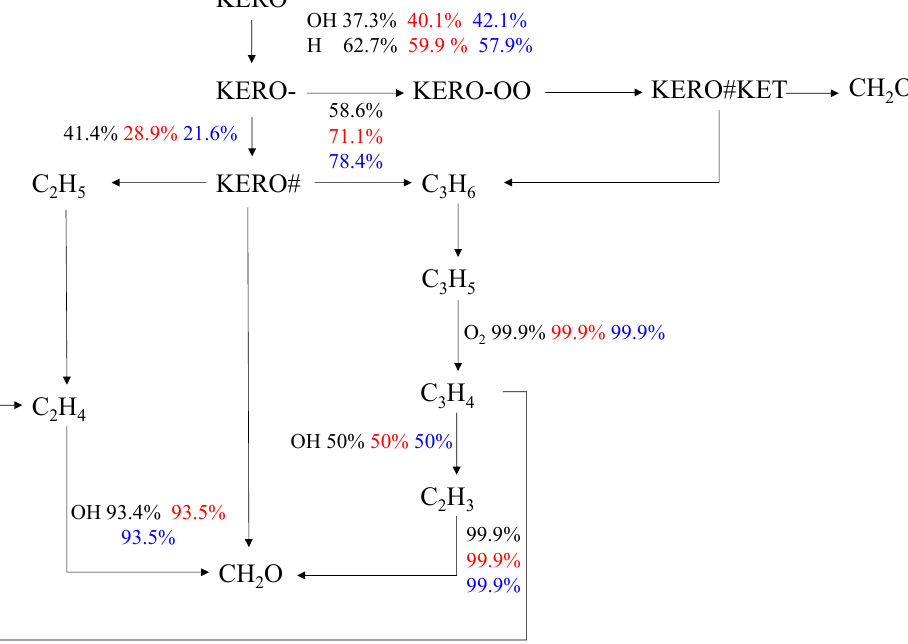
Figure 10. Effects of initial pressure on the chemical reaction path of kerosene (T = 800 K; Φ = 1; black: P = 15 bar; red: P = 20 bar; blue: P = 25 bar) .